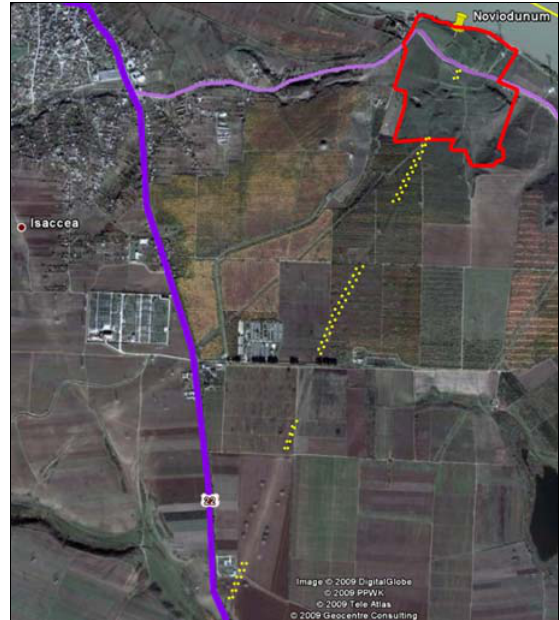
Figure 2. Noviodunum archaeological reservation limits (red) and the presumed roman road (dotted yellow to complete the visible marks), as seen on a Google Earth satellite